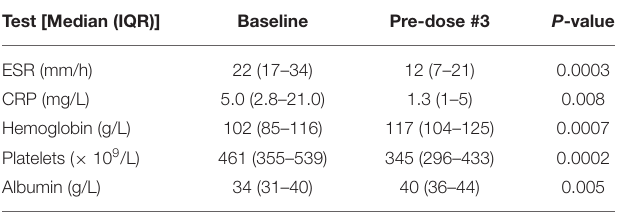
TABLE 3 | Key laboratory